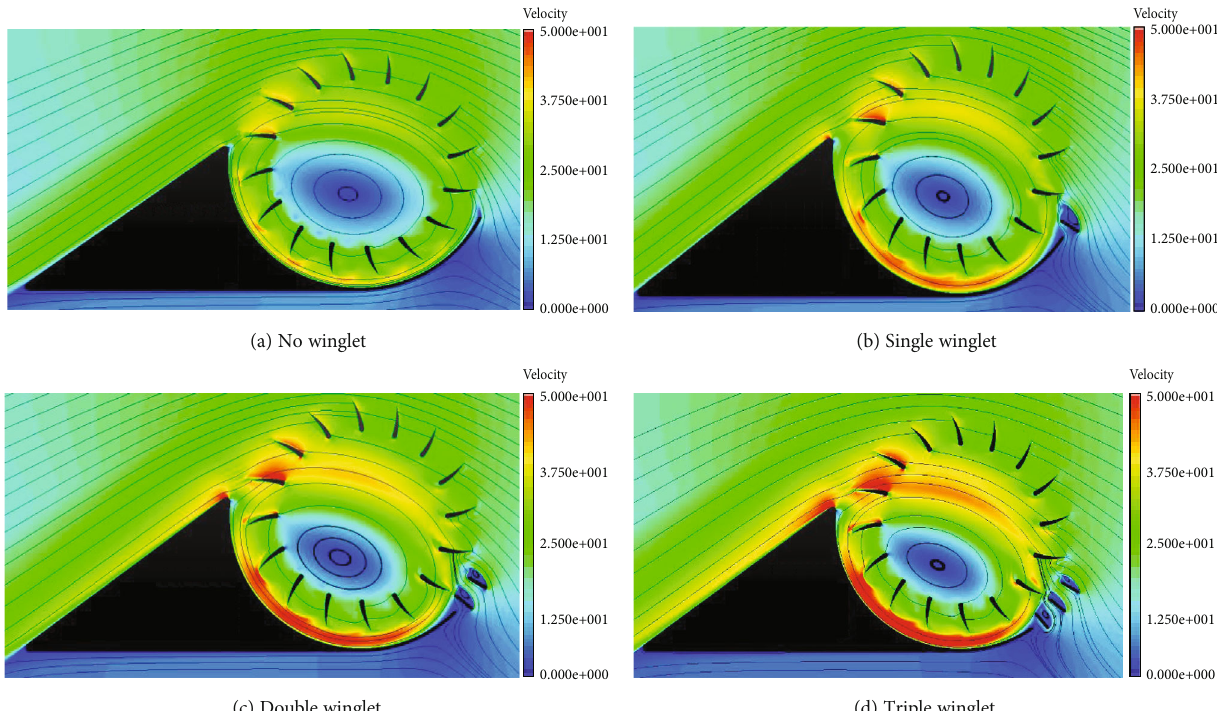
Figure 20: Velocity nephograms and streamlines of di ff erent number leading edge winglets (installation angle = 90 ° , v = 12 m/s, α = 0 ° ).